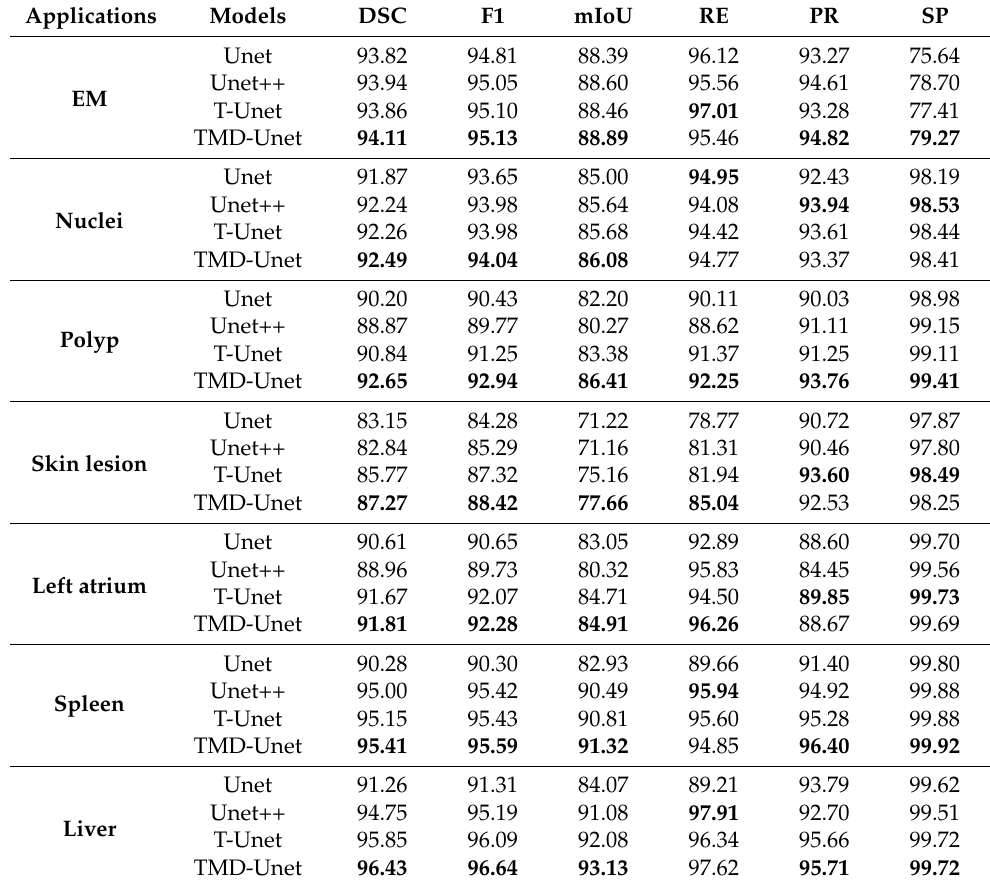
Table 4. The comparison of the segmentation results. All metrics are in (%). The bold denotes the best